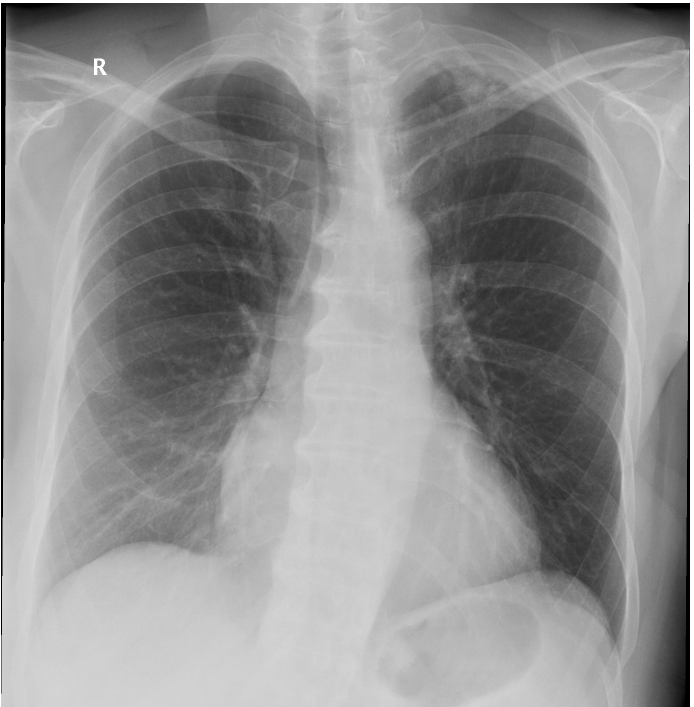
Figure A1. False Negative image incorrectly classified by DLAD software during internal software validation. The software failed to detect a rib